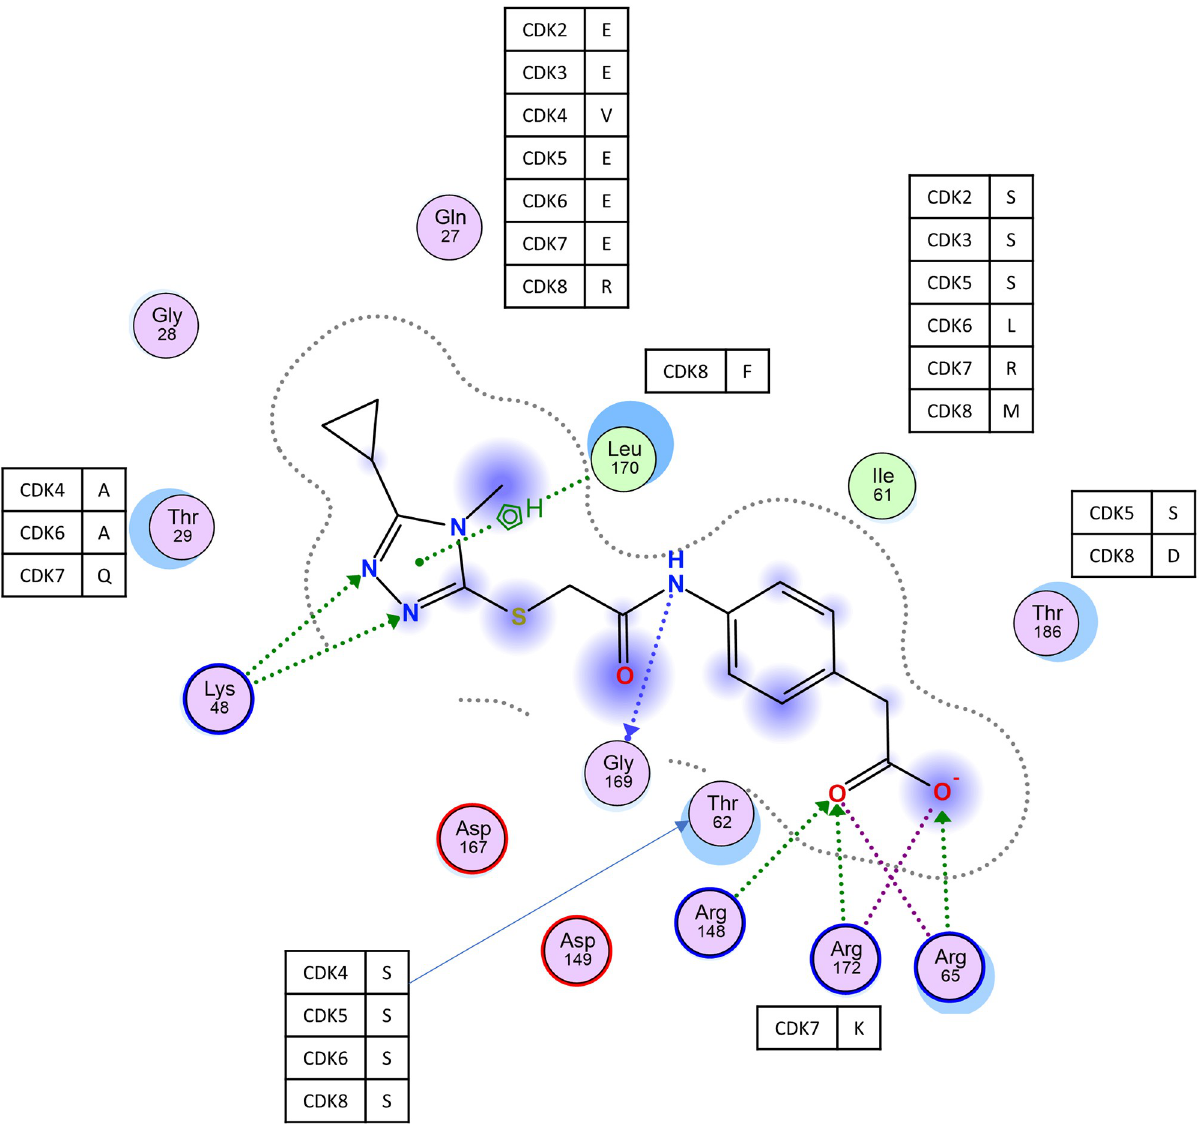
Fig 5. A 2D interaction diagram of the docking pose of 127 in the ligand-binding site of CDK9. Hydrophobic and polar amino acids are shown in green and purple circles, respectively. Interactions with the amino acids are depicted as green dotted arrows (side chain acceptor) or green dotted lines (aromatic). Amino acid variations among CDKs are shown in the